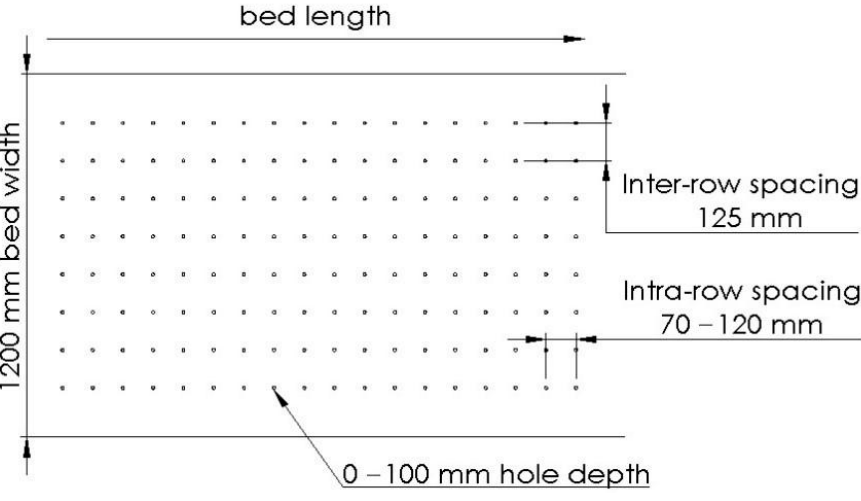
Figure 2. A layout of nursery beds.